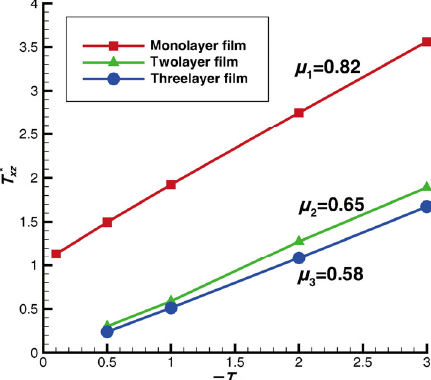
T  vs. the load T  for the xz zz  of the l -layer fluid film is l